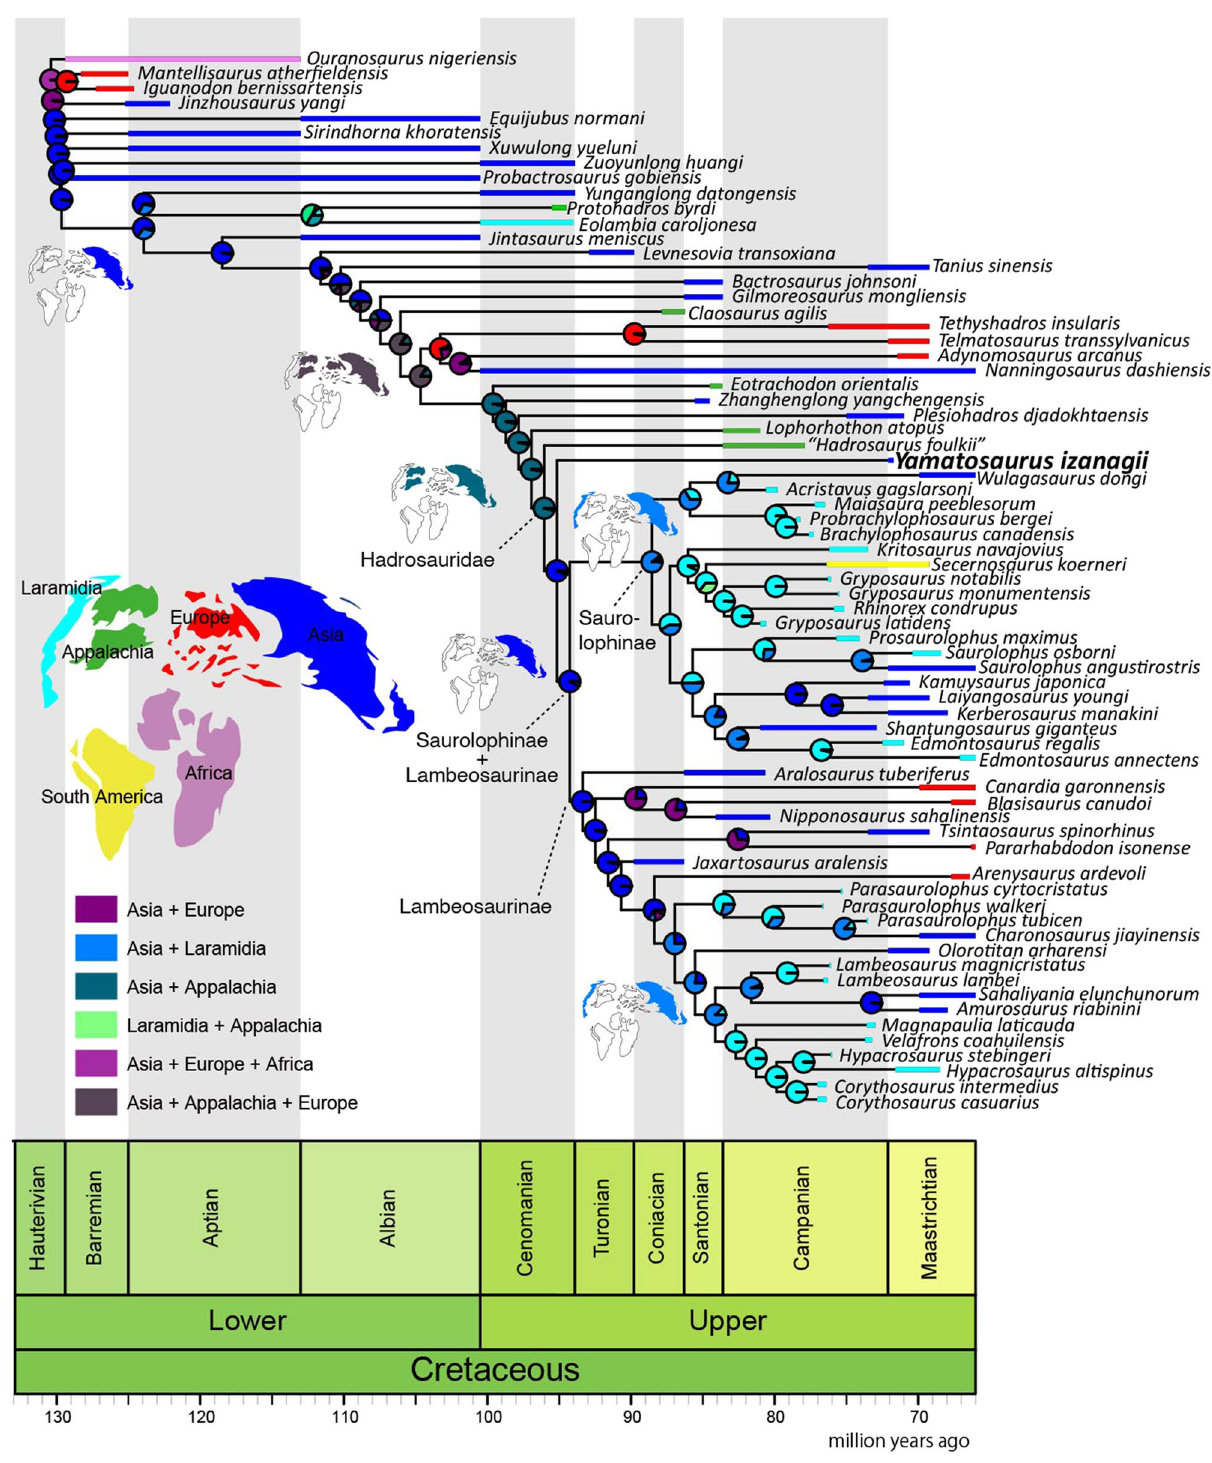
Figure 8. Result of the biogeographic analysis using the “starting” dispersal multiplier matrix. Refer Supplementary Figs. S1, S2 for the analyses using the “relaxed” and “harsh” dispersal multiplier